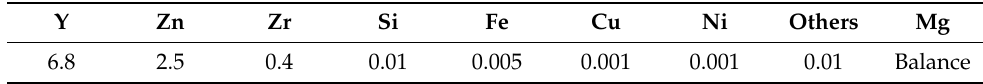
Table 1. Chemical composition of Mg-6.8Y-2.5Zn-0.4Zr (wt.%) alloy as determined by means of optical emission spectrometry (OES, Spectro/Ametek,